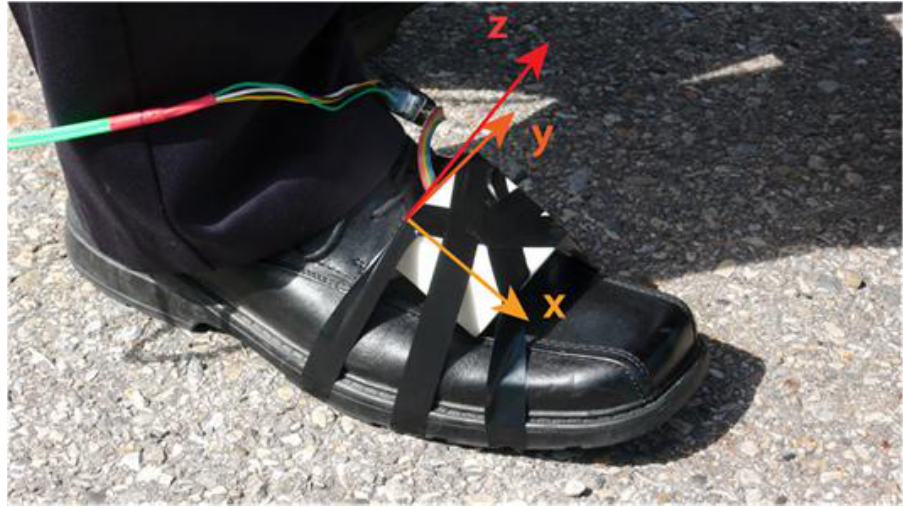
Figure 10. IMU attached on the foot and used as a reference for step detection